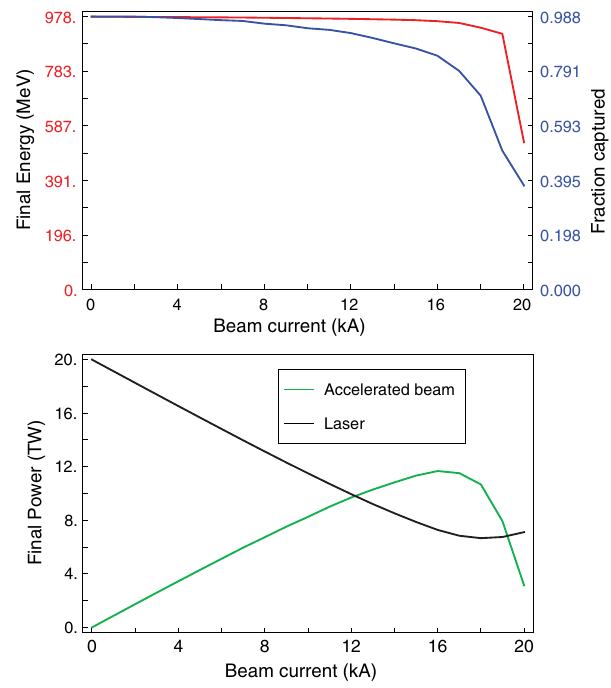
FIG. 10. Output IFEL parameters as functions of input beam